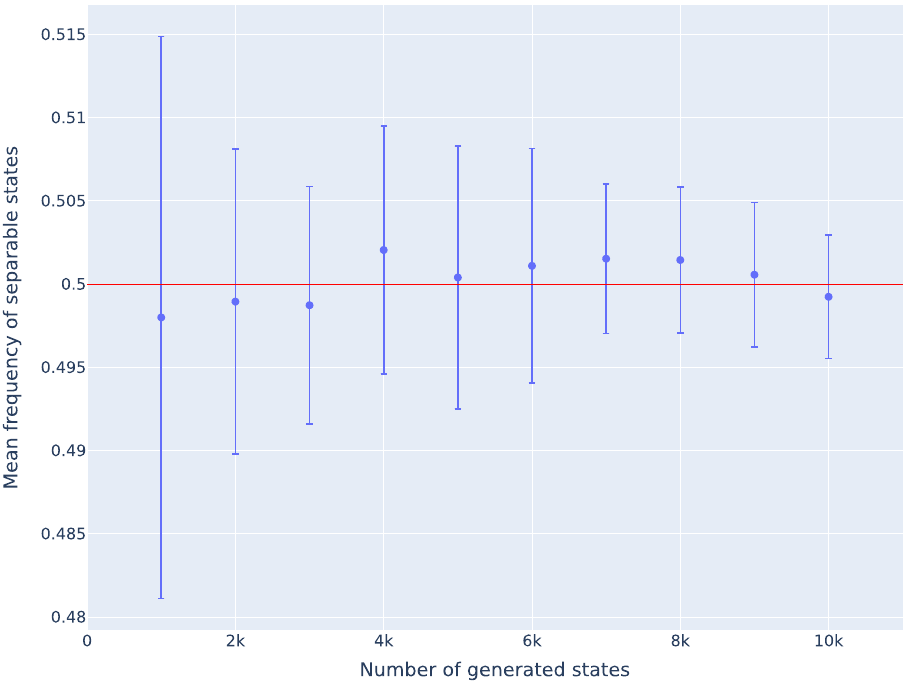
Figure 1. Relative frequencies of separable states in M 2 . For each sample size, 10 sets of randomly generated states are generated. The figure shows the empirical mean and standard deviation for the frequencies of separable